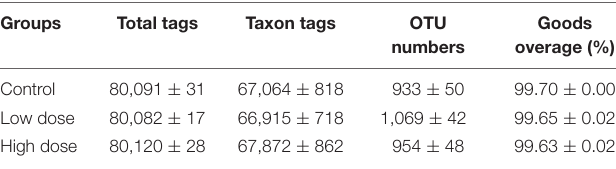
TABLE 1 | Number of total tags, taxon tags, operational taxonomic units (OTUs), and Goods coverage in 16S rRNA libraries of control group (0 mg/kg 6-MBOA),